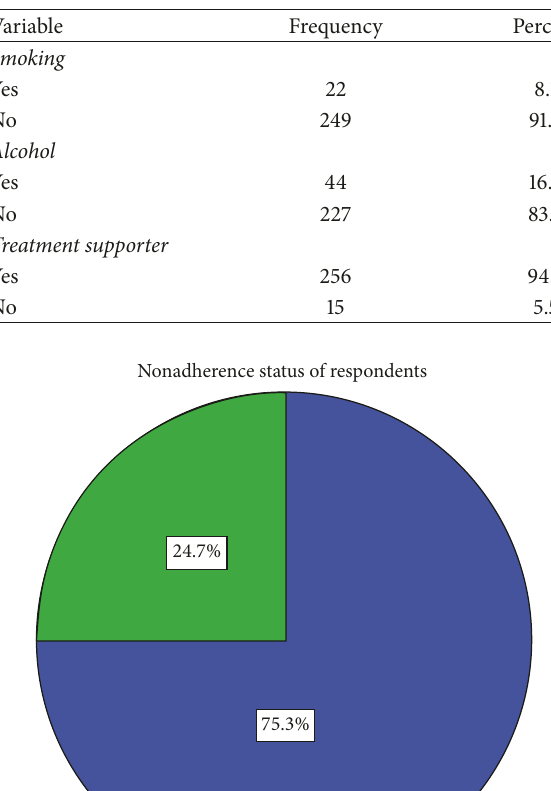
Table 3: Healthcare system related characteristics of the TB patients that attended TB clinics at governmental health institutions of Arba Minch town, Southern Ethiopia, 2017 (𝑁 = 271)